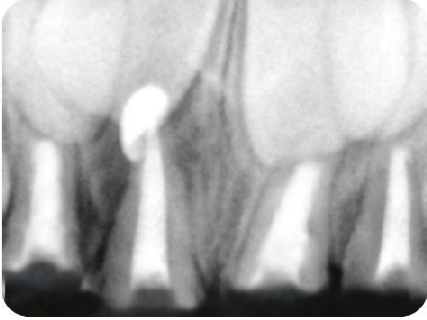
Figure 3: Postobturation radiograph in relation to 51, 52, 61, and 62.